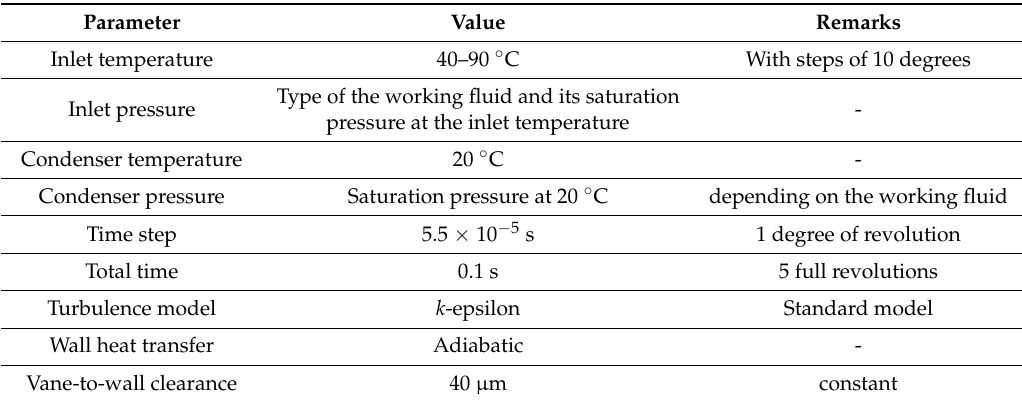
Table 1. Boundary conditions and model